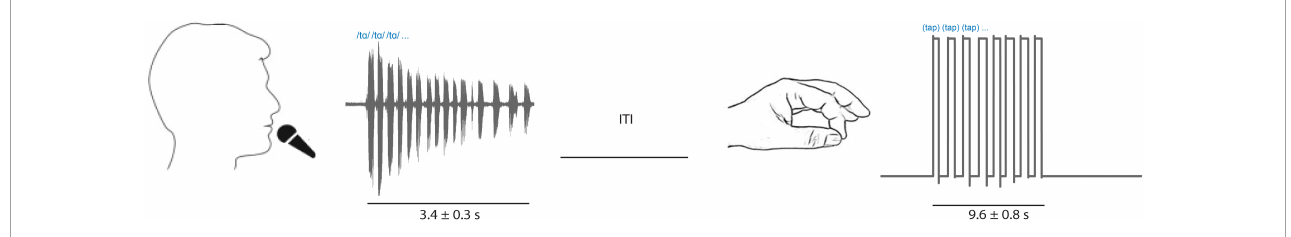
FIGURE1 Tasks included interleaved speech (sustained vowel phonation [/ /] and diadochokinetic [/t t t /]) repetitions captured by a microphone ( left ; example/t t t /audio signal shown) and limb movement trials ( right ; contralateral finger tapping, example goniometer tracing shown). Inter trial interval was